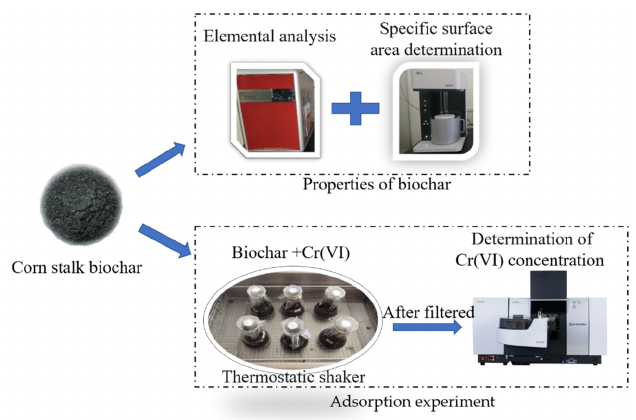
Figure 1. The schematic illustration of adsorption experiments.